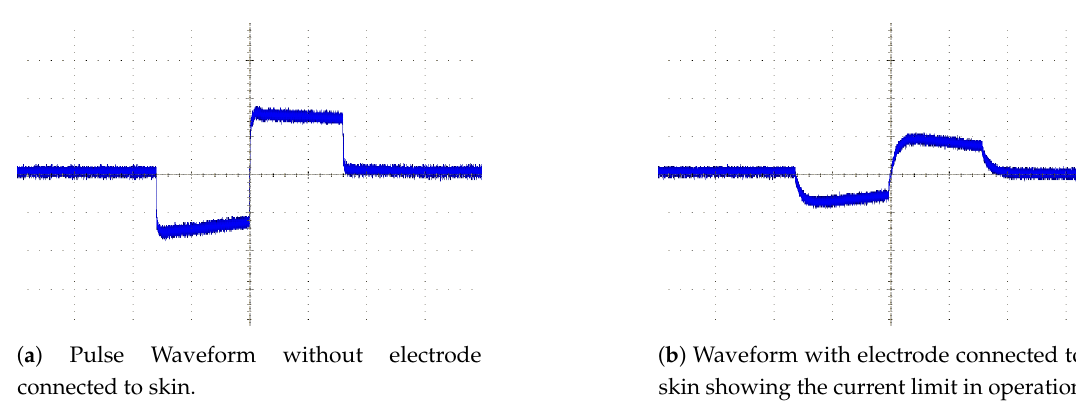
Figure 6. Stimulator output waveform options.